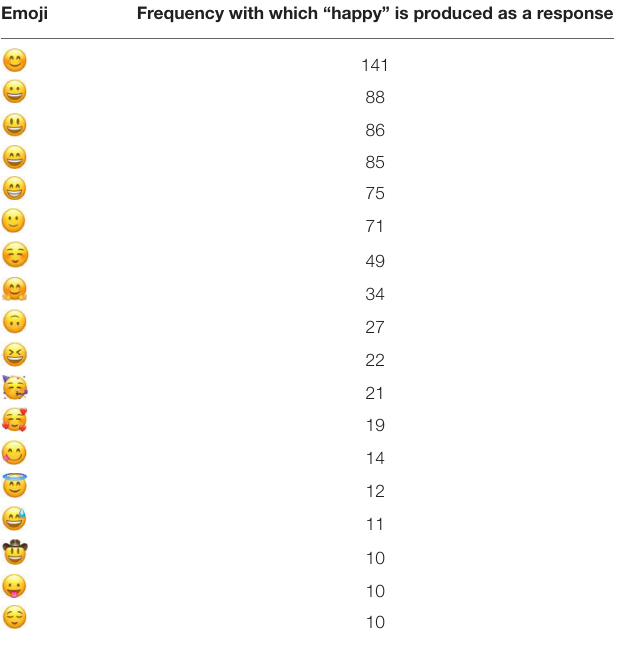
TABLE 2 | Emoji stimuli that elicited the word associate “happy” as a response at least 10 times across subjects (this is an arbitrary boundary used for simplicity of presentation).